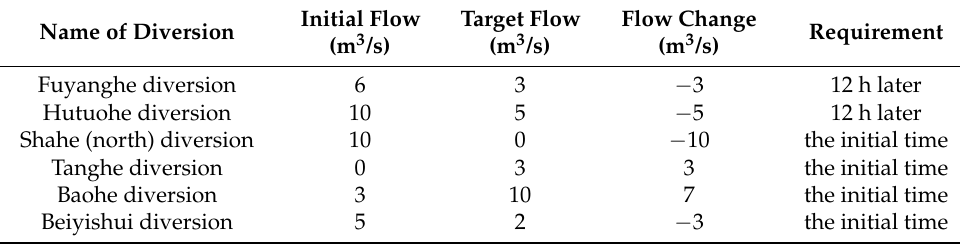
Table 1. The initial and target diversion flows.